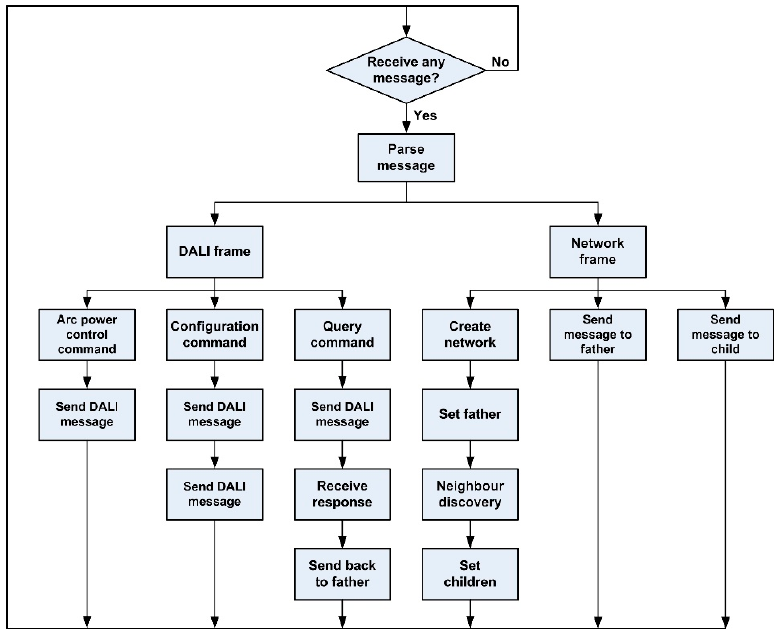
Figure 15. Microcontroller program flowchart.